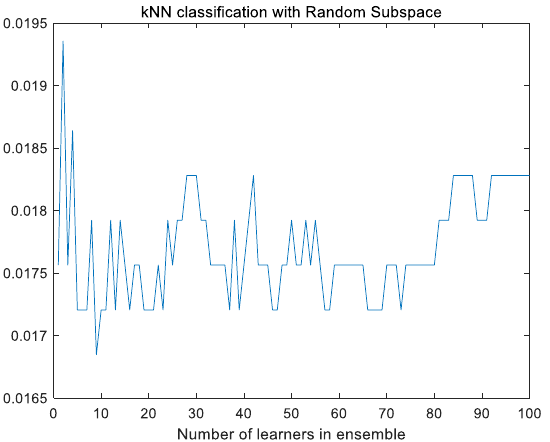
Figure 12. Number of learners in ensemble vs. 10-fold classification error for k = 1 and d = 22 .